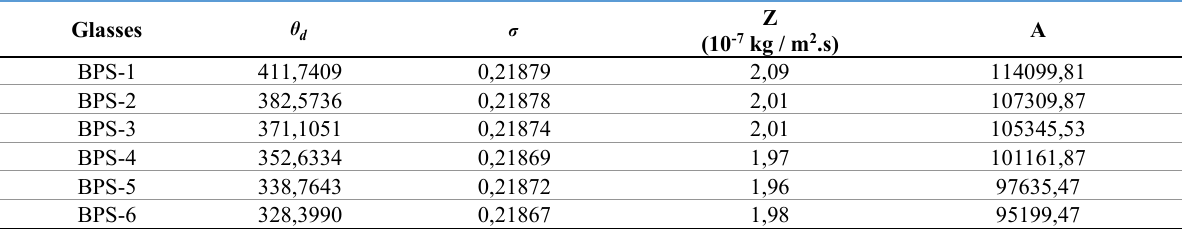
Poisson Coefficient ( ) σ , Acoustic Impedance (Z) and Coefficient of Thermal Expansion